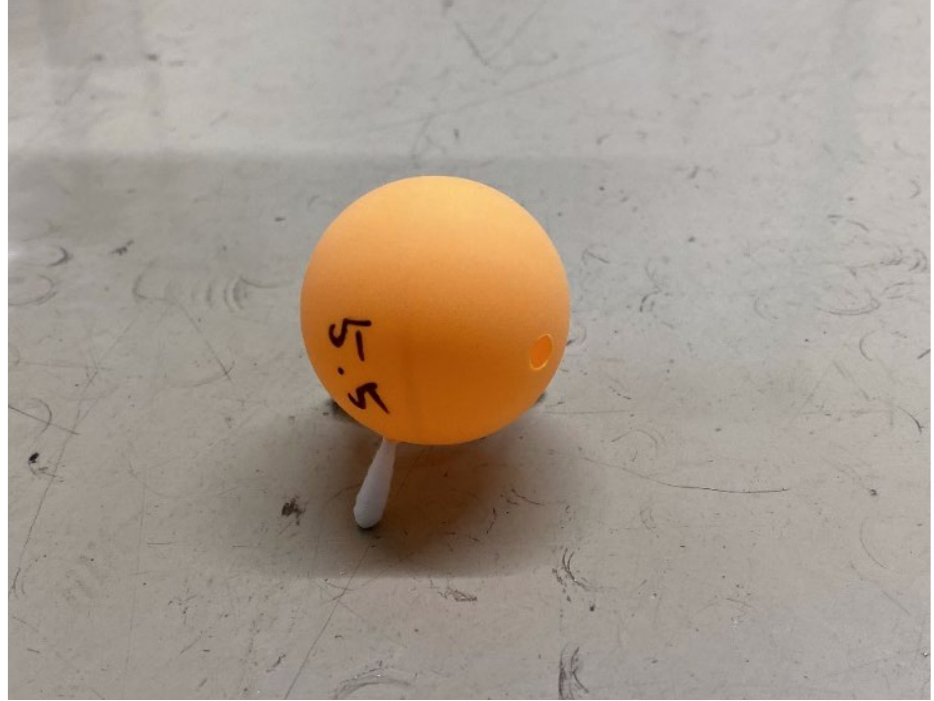
Figure 8. Appearance of a ball with a round-tipped cotton swab (The diameter of the ball is 44 mm. The cotton swab length is 16 mm. Its weight is 2.7 g.).